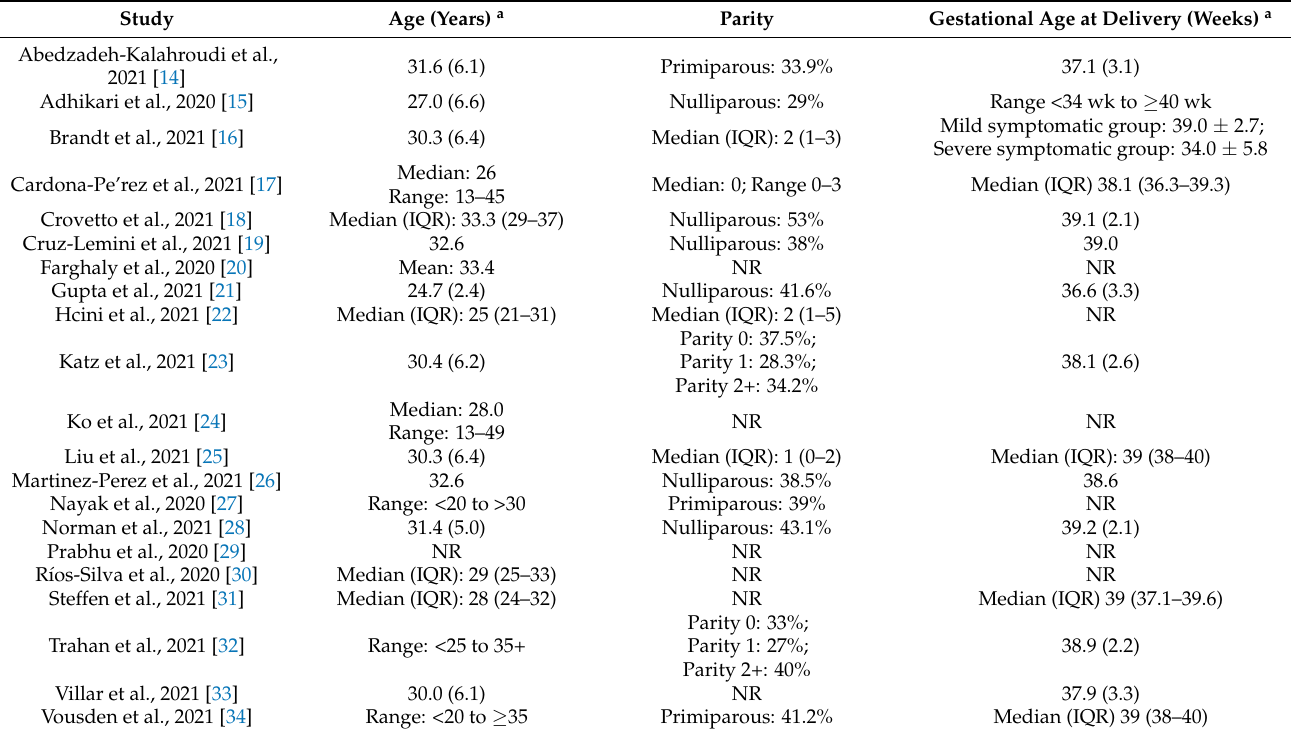
Table 2. Characteristics of COVID-19 infected pregnant women.